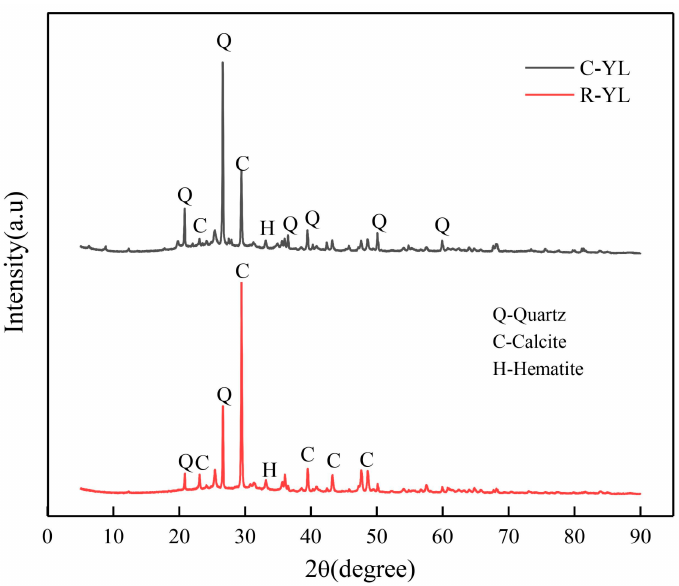
Figure 2. XRD analysis of NM and